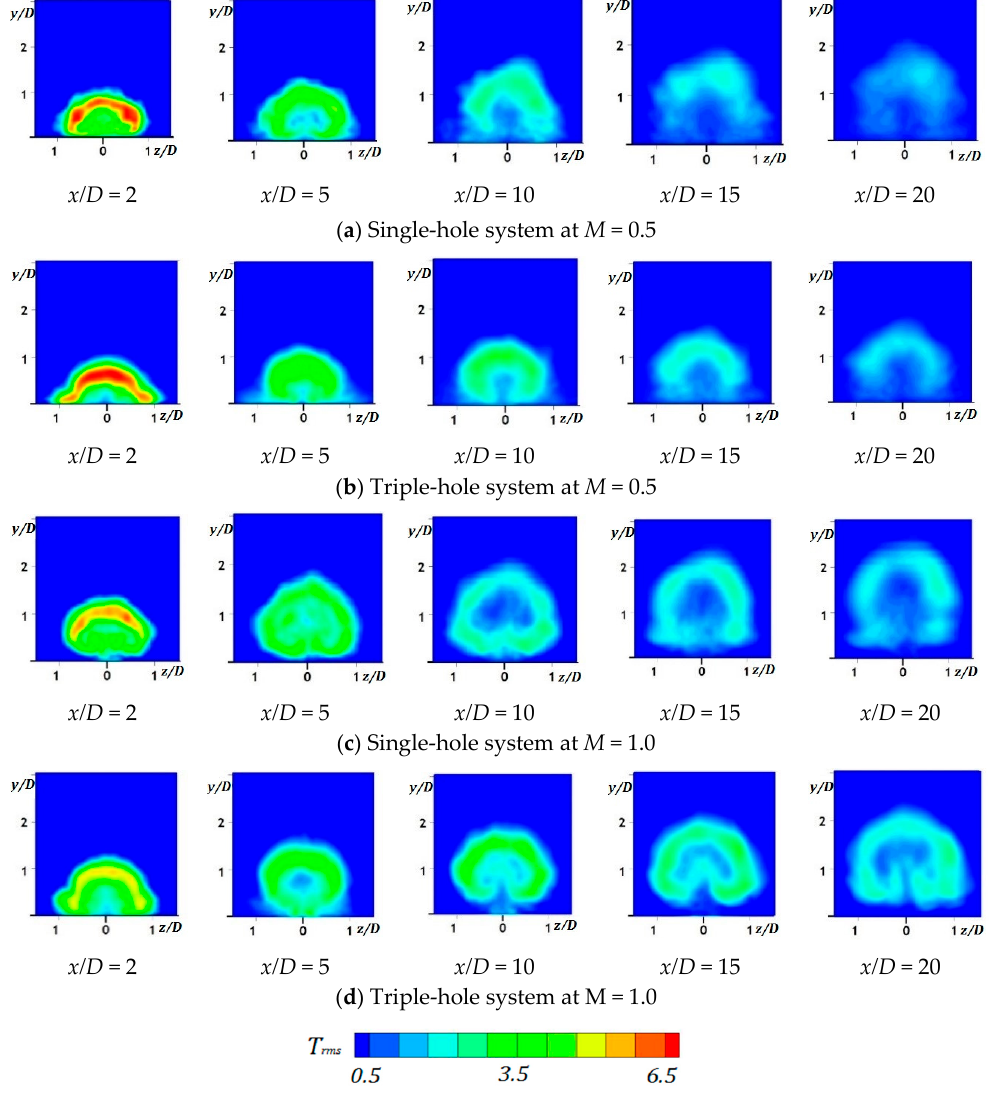
Figure 18. Cross-sectional contours of the T rms.